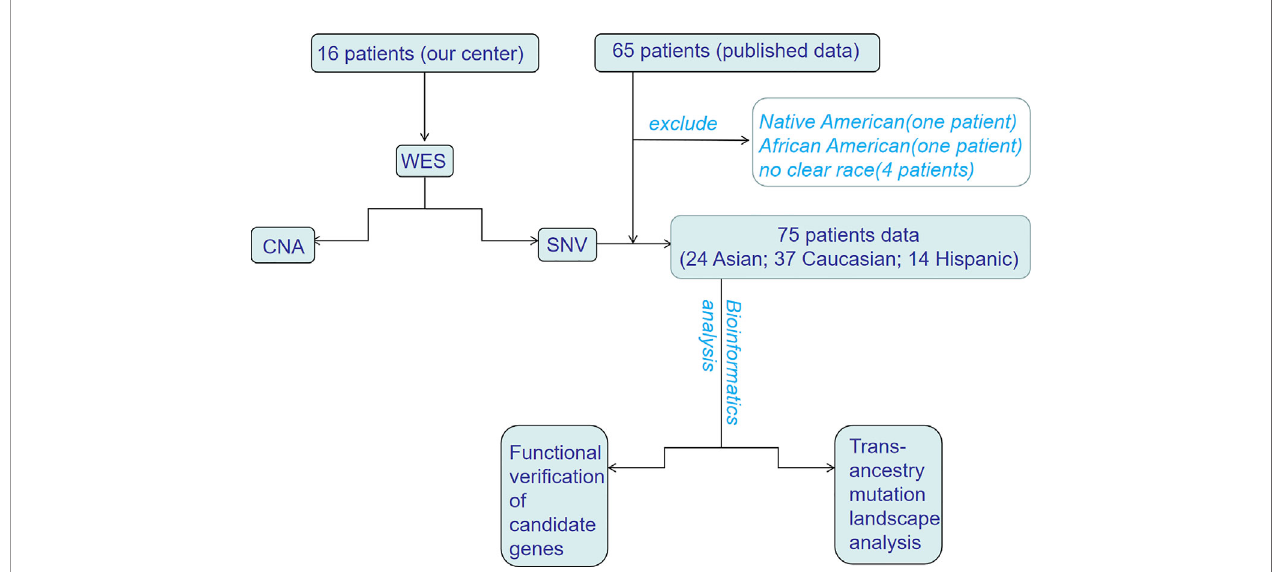
FIGURE 1 | The fl owchart of trans-ancestry WES of hepatoblastoma. WES, whole-exome sequencing; SNV, single nucleotide variant; CNA, copy number